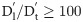
The effect of blood rheological model and flow rate on diffusive mass transport behaviour.a) The plot of the normalised drug concentration gradient for the case in which blood is modelled as a Newtonian fluid revealed five peaks and troughs, labelled A, B, C, D and E. Local minima (A and E) show where drug is removed from the tissue while local maxima (B-D) show where it diffuses into the tissue. b) The dashed blue line shows the distribution of the normal component of the blood velocity along a line 0.1 strut widths above the lumen-tissue interface. Comparison with the red dc/dn line confirmed that the upward flow at points A and E resulted in loss of drug from the tissue due to convection. The purple ∂c/∂x’ line revealed that drug transport in the horizontal direction was significant between points A and B, and at points C and E. c) the distal recirculation zone was found to remove drug from the tissue for non-Paclitaxel drugs, although this behavior diminished as Dl'/Dt'≥100. d) The non-Newtonian blood rheological models produced similar dc/dn patterns to the Newtonian model; however, their local maxima and minima were up to 59% smaller in magnitude. The size of these peaks and troughs was found to be directly related to the recirculation lengths predicted by each model. Hence, the choice of rheological model not only influenced the fluid dynamics, but also the drug transport behaviour.